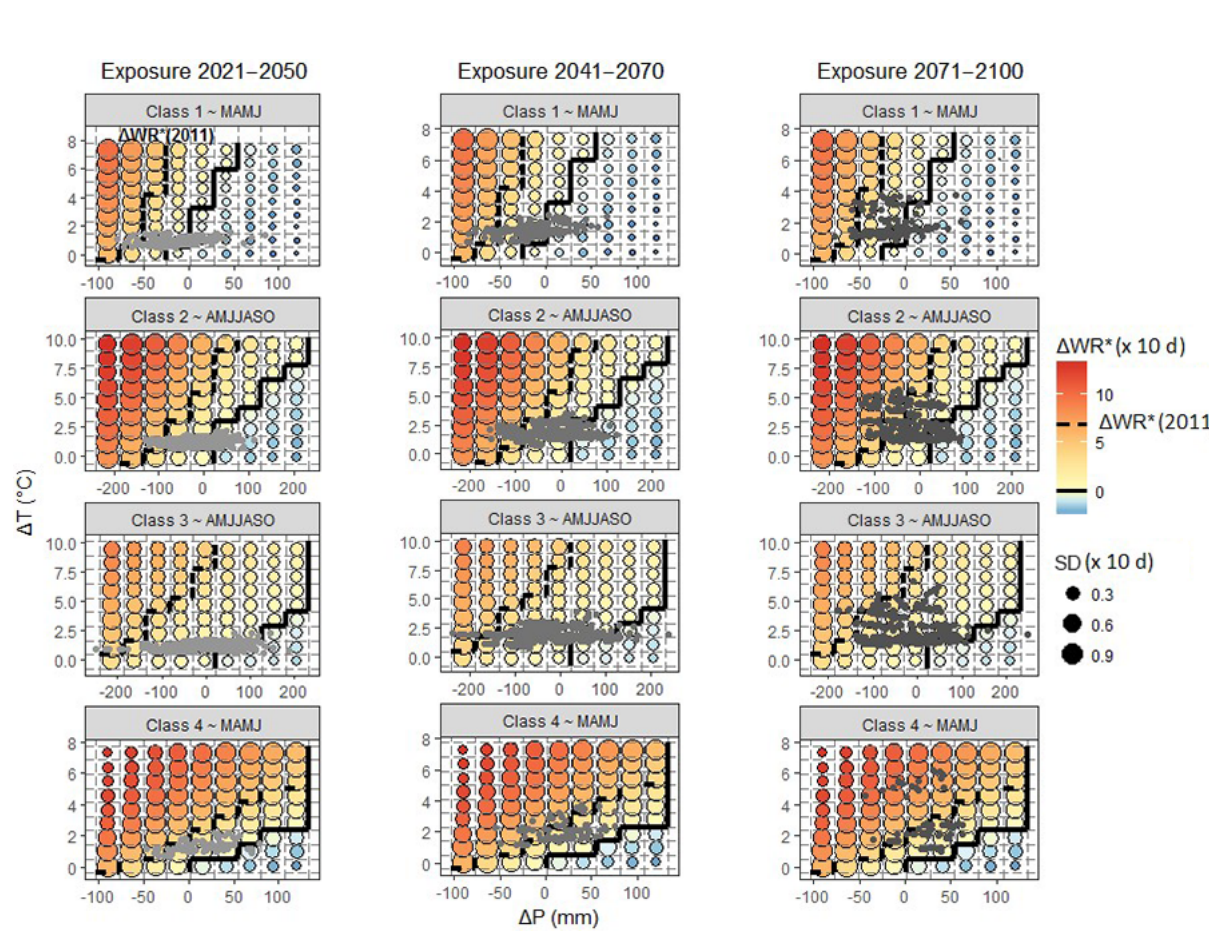
Figure 14. Representative climate response surfaces for each class, including both exposure and performance characterizations.